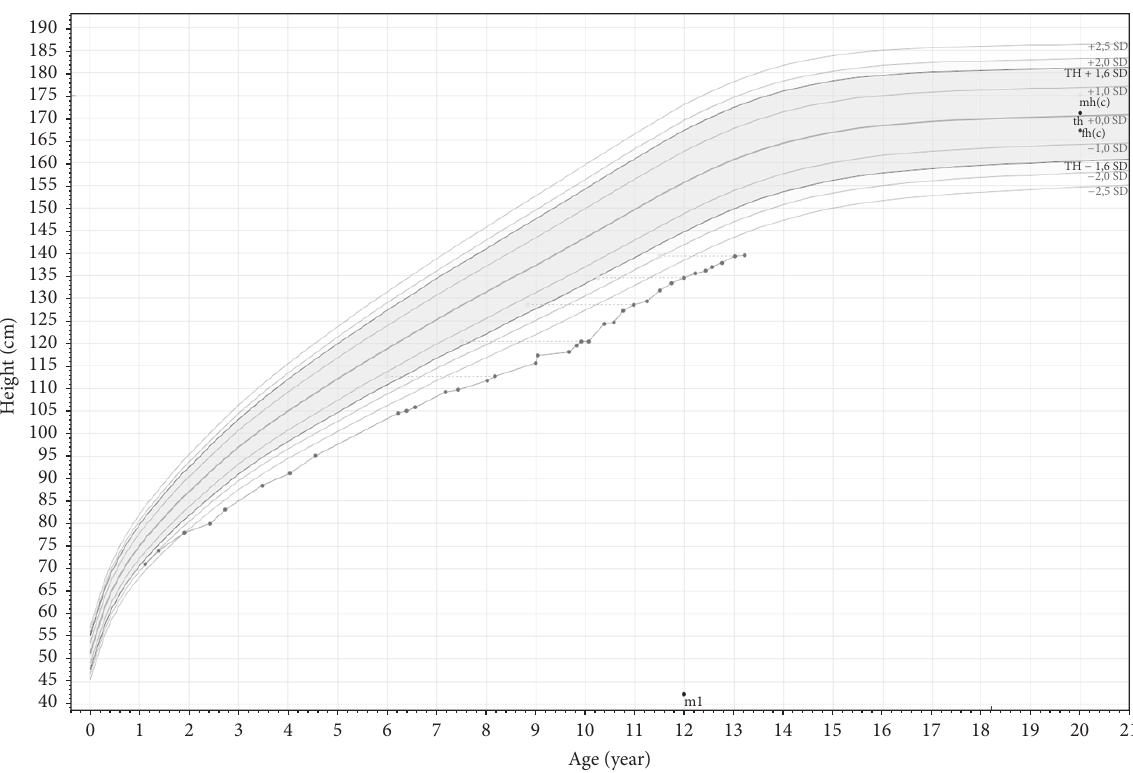
Figure 1: Growth curve (height for age).